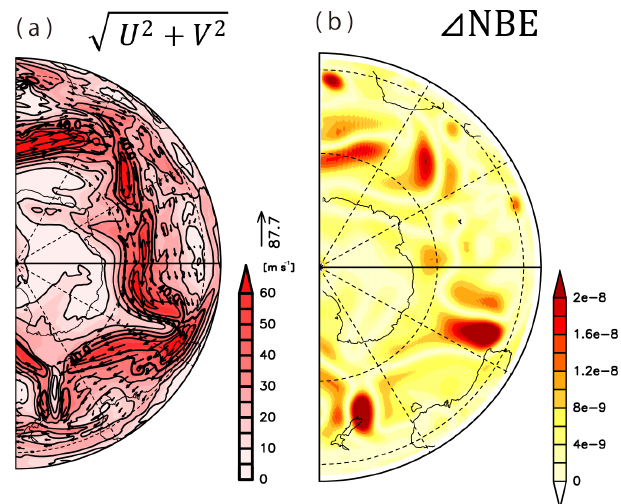
Figure 15. Snapshots of horizontal maps of (a) the absolute hor- izontal wind velocity and (b) the residual of the nonlinear bal- ance equation ( (cid:49) NBE ) at the height of 10km at 03:00UTC, 21 March 2015. The vectors in (a) denote the directions and the magnitude of the horizontal winds. The contour intervals in (a) are 10ms − 1 . The data are from the NICAM